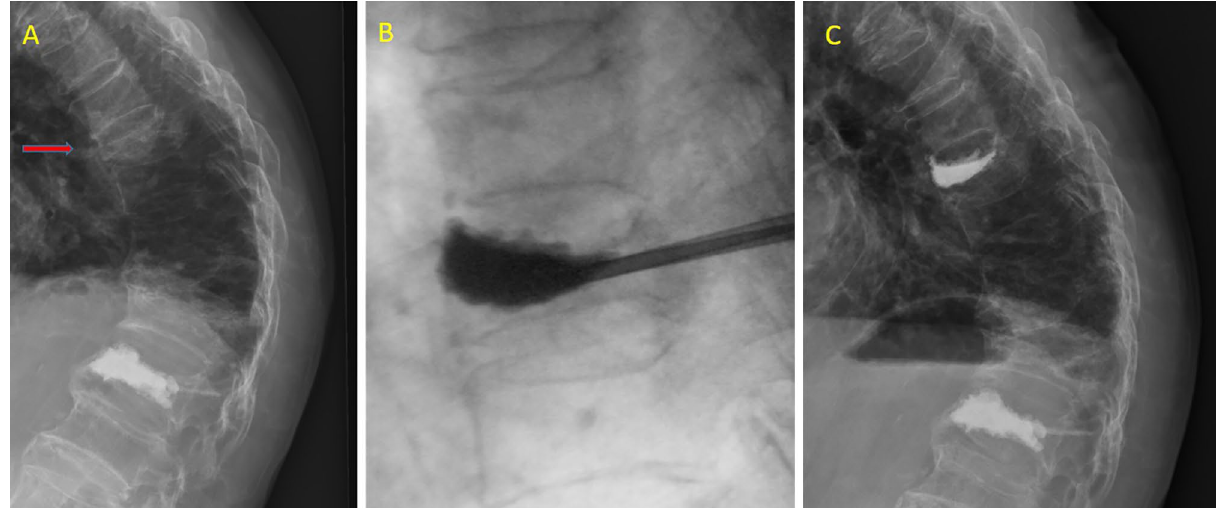
Figure 2. A case of T8 vertebral compression fracture treated with high-viscosity cement vertebroplasty. ( A ) The arrow in the preoperative lateral radiograph points to the fracture level. ( B ) Intraoperative radiograph. ( C ) Postoperative lateral radiograph shows fractured vertebrae filled with high-viscosity